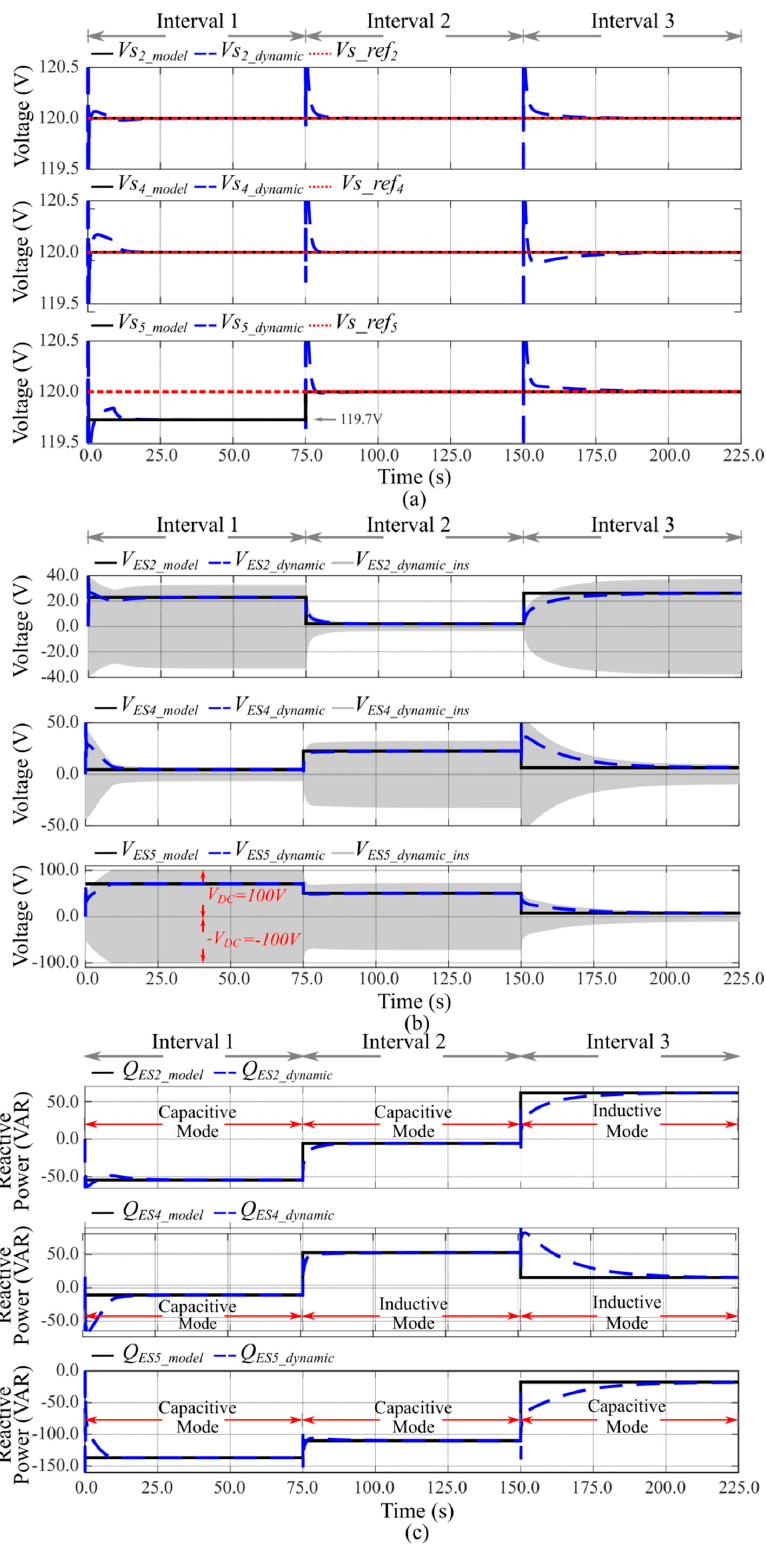
Figure 10. Electric quantities at constant reference voltages and changes in the active power. ( a ) Node voltages, ( b ) ESs voltages, and ( c ) ES reactive power and operation modes.